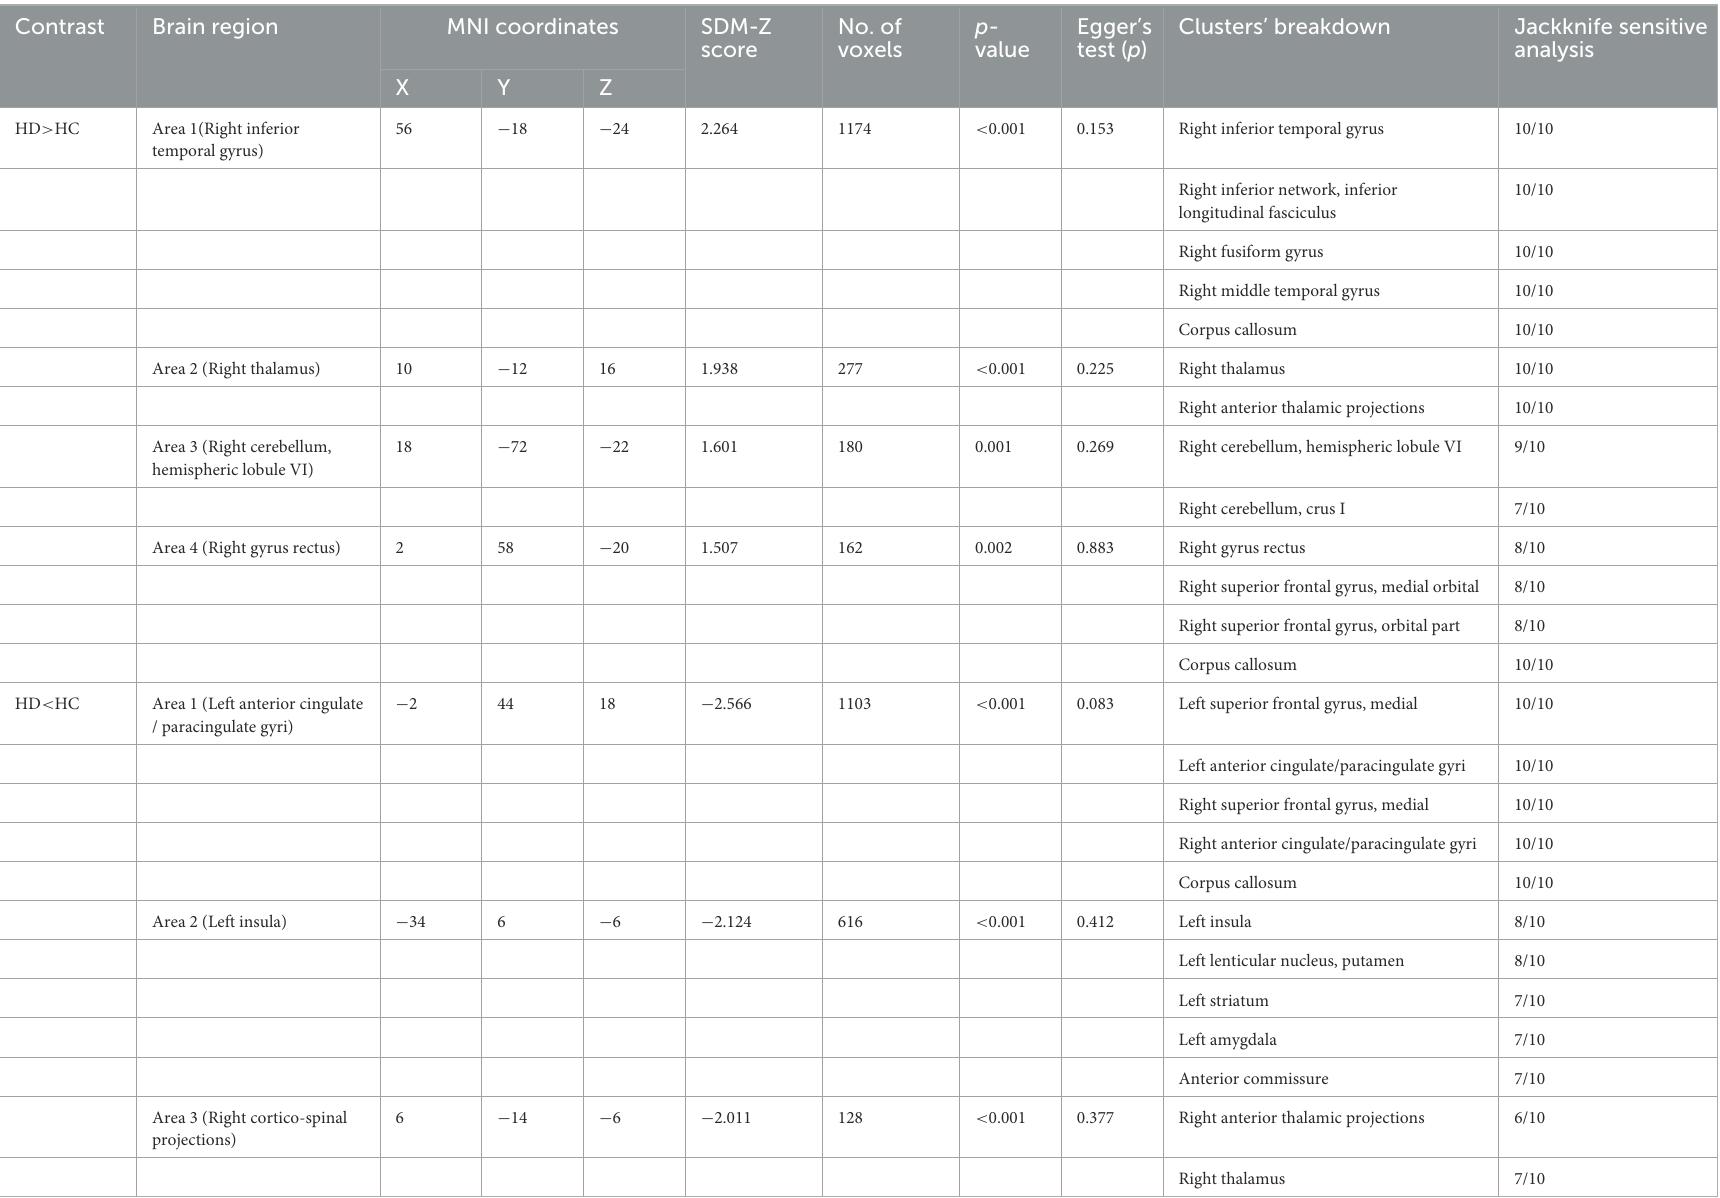
TABLE 2 The mean meta-analysis: altered resting-state activity in HD patients relative to